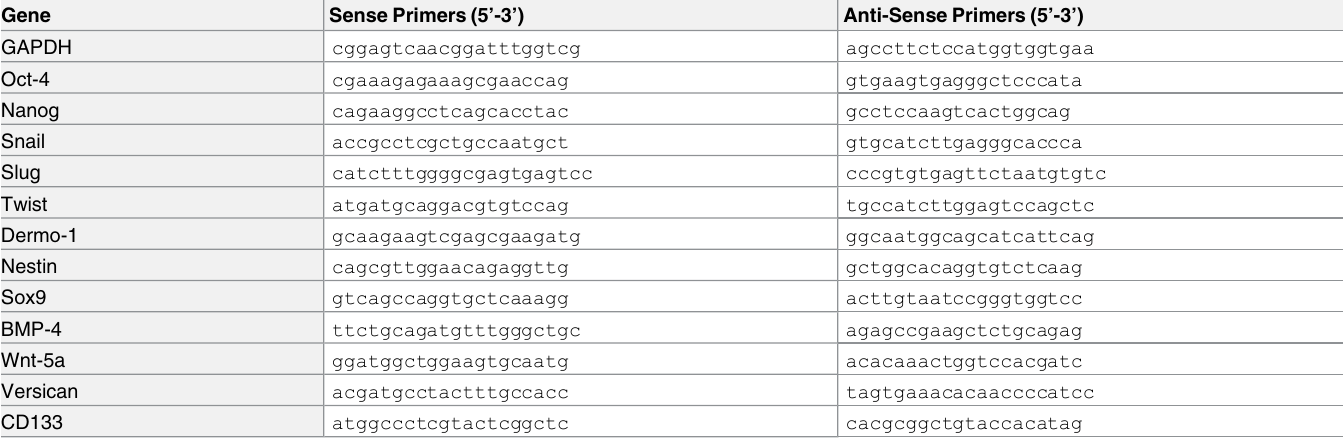
Table 1. List of genes and primer sets used in the